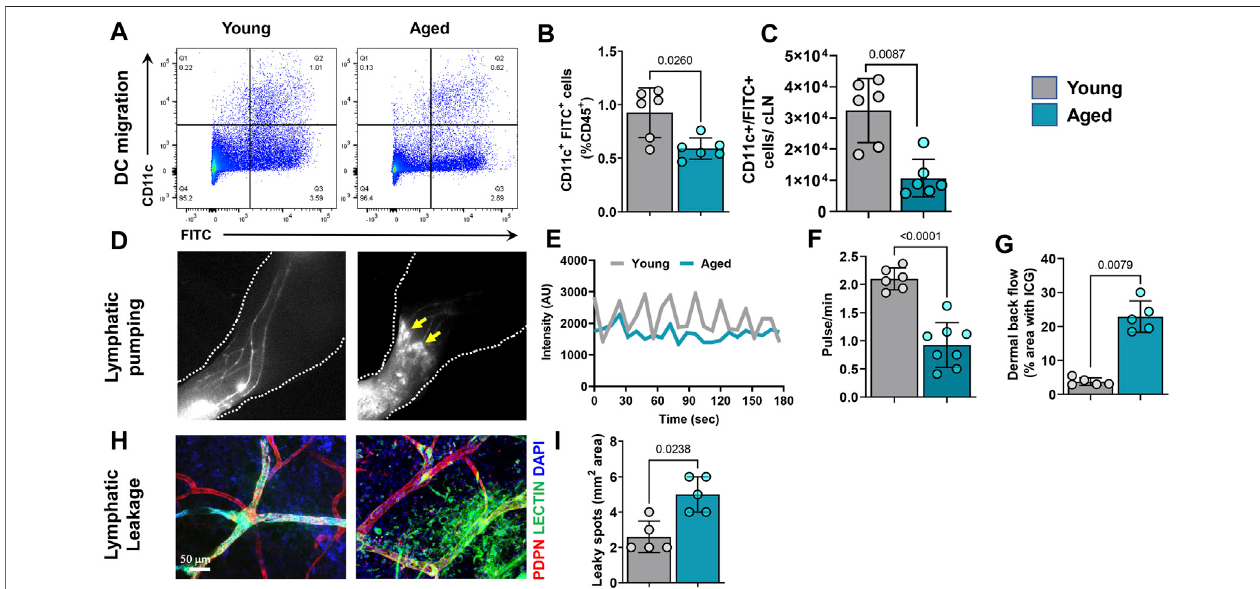
FIGURE 3 | Aging causes decreases in dendritic cell (DC) migration and lymphatic pumping and increased leakiness in lymphatic vessels. (A) Representative dot plotsofFITC+/CD11c+ DCsfromdeepcervicallymphnodes (whichdrainearskin)afterFITCpaintingoftheearskin. (B) Quanti fi cationofFITC+DCsasapercentage of CD45+ cells from cervical lymph nodes. (C) Quanti fi cation total number of FITC+ DCs per lymph node. n = 6 mice per group from two independent experiments. (D) Representative hind limb ICG lymphangiography NIR images showing hind limb collecting lymphatic vessels, dermal back fl ow, and dye pooling (arrows) in aged mice. (E) Graphicalrepresentation ofICG intensitypeaks plottedagainst time in hindlimbs ofyoungand aged mice. (F) Quanti fi cation ofthe number oflymphaticpulses perminuteinyoungandagedmice. (G) Quanti fi cationofdyepooling,whichrepresentsdermalback fl ow. n =5 – 7micepergroupfromtwoindependentexperiments. (H) Representativeconfocalimagesofwhole-mountedearskinfromyoungandagedmiceshowingFITC-lectinleakageinlymphaticvessels. (I) Quanti fi cationofFITC-lectin leakage (total FITC-lectin-containing area). n = 5 mice per group. All quanti fi cations are mean ± SD, unpaired Student ’ s t